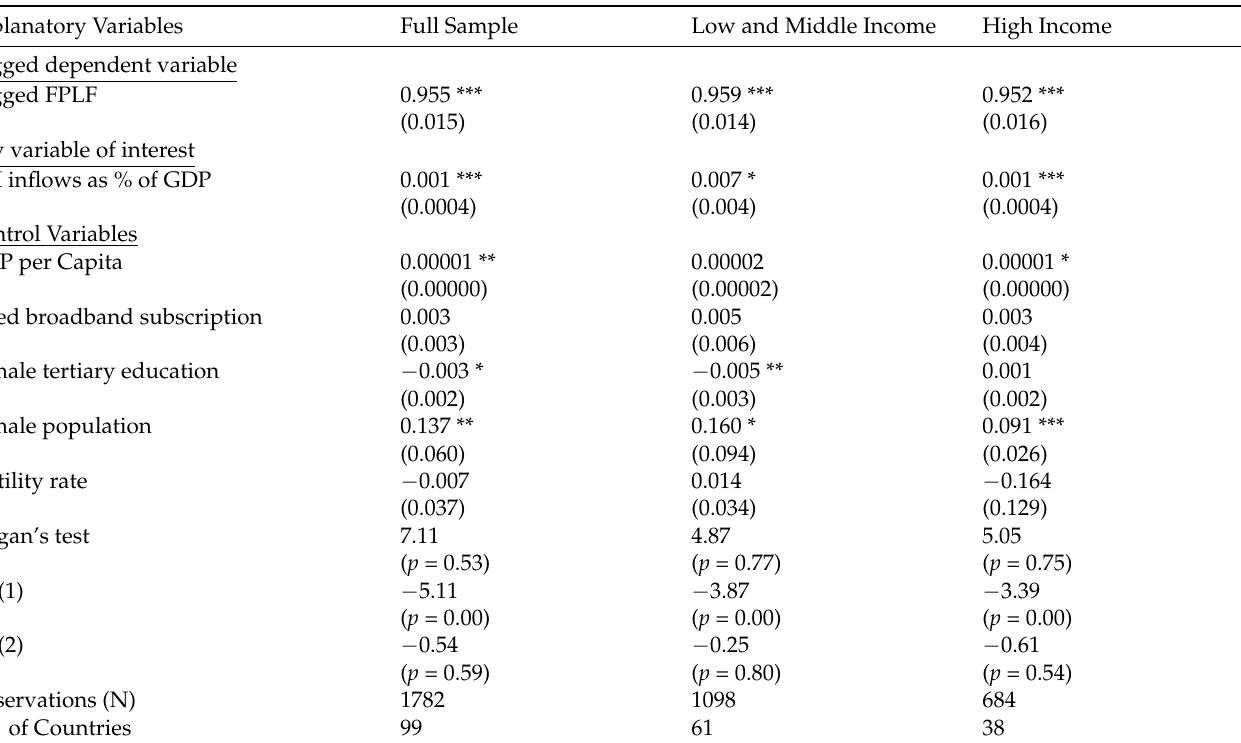
Table 3. Impact of FDI on Female participation in the Labor Force (FPLF) Using System GMM